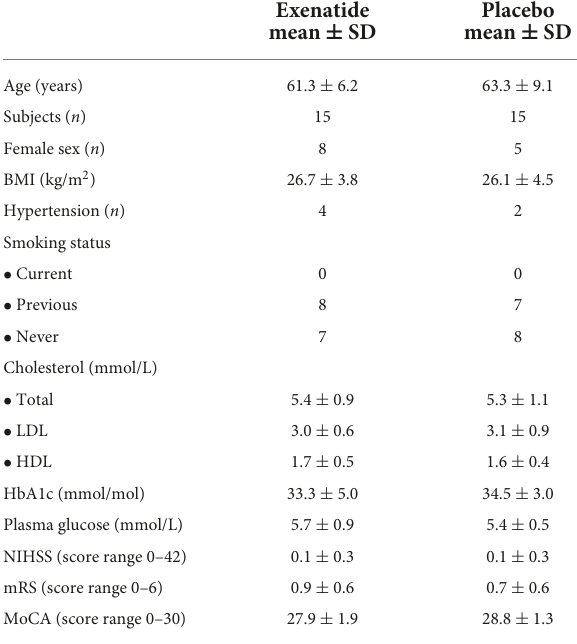
TABLE 1 Subject characteristics ( n =